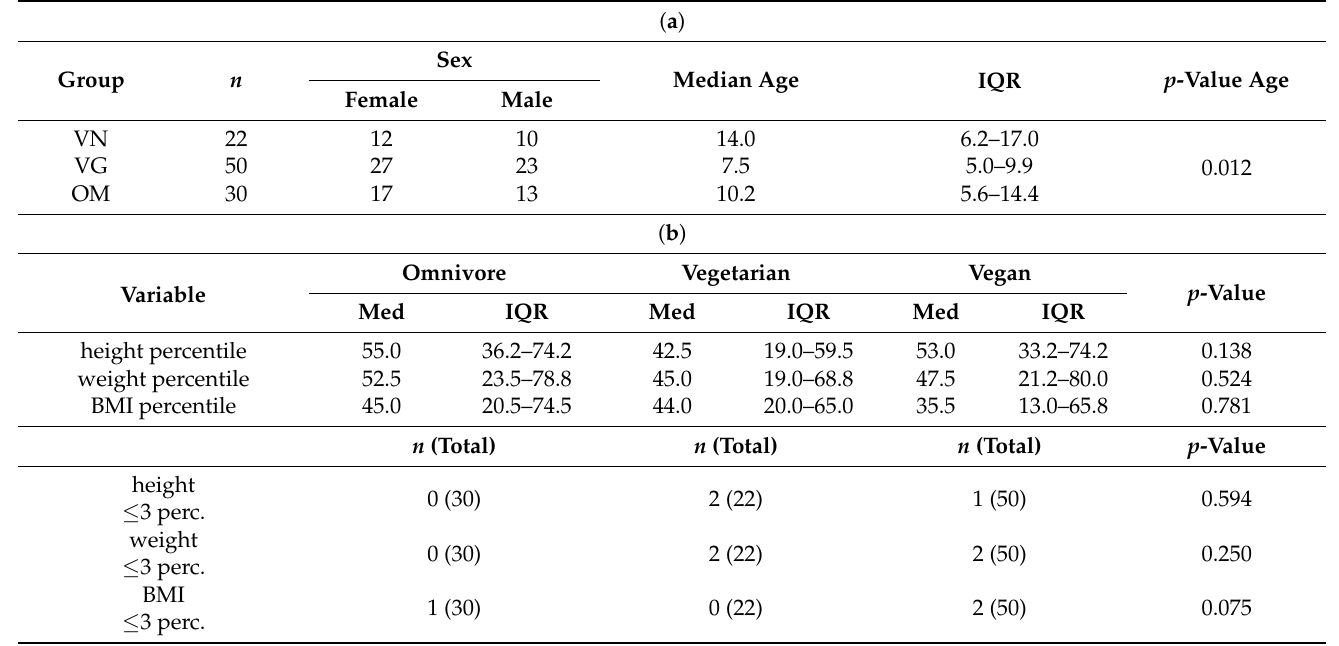
Table 5. ( a ) Description of the basic characteristics of VG/VN/OM “Schoolers” (aged 4–18 years); ( b )